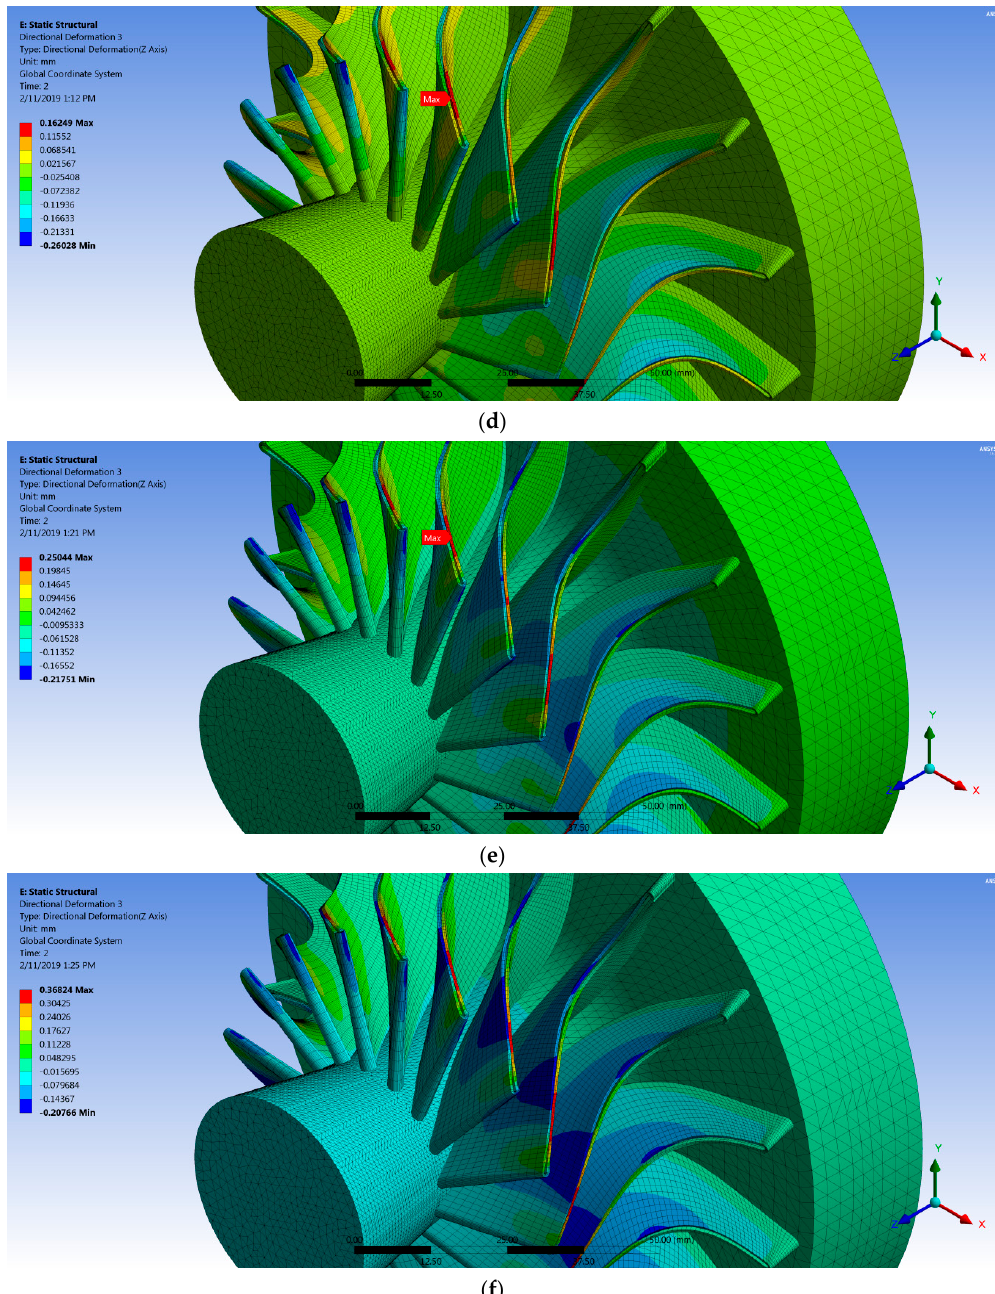
Figure 18. Directional deformation ( z direction) for ( a ) steel rotor blades and ( b – f ) composite rotor with different fiber orientations: ( b ) 20°; ( c ) 30°; ( d ) 40°; ( e ) 50°; and ( f ) 60°.